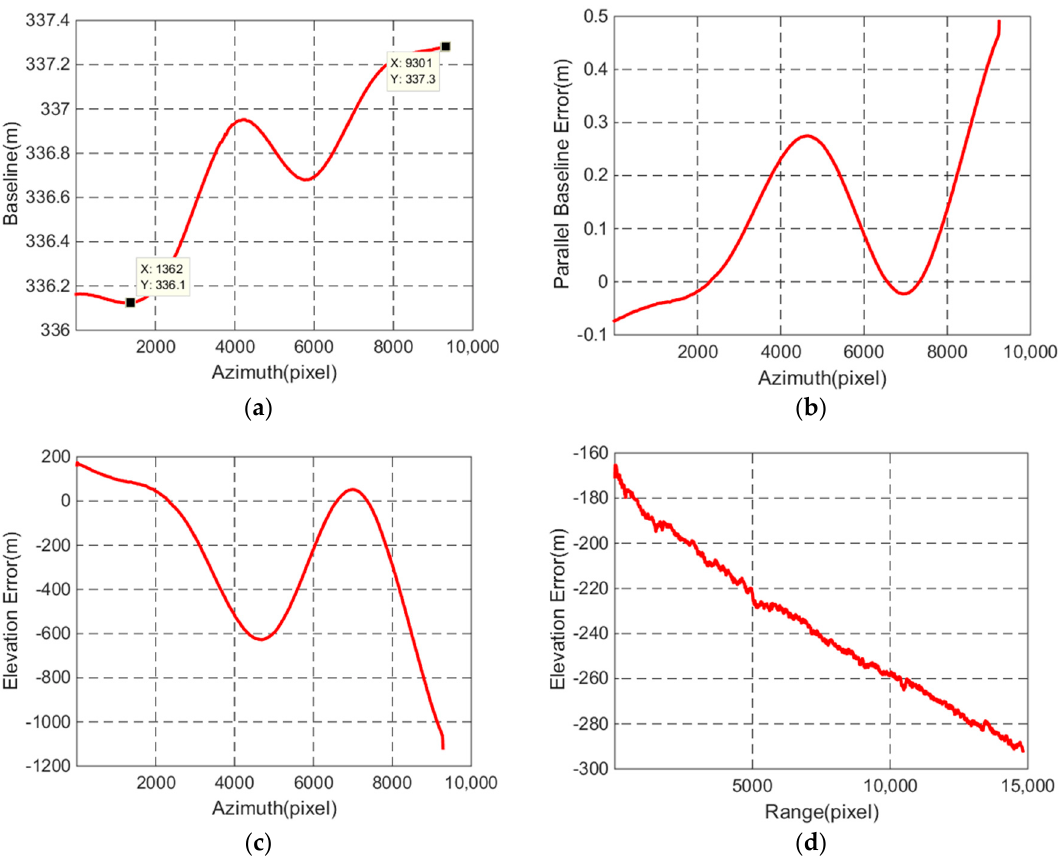
Figure 9. Different error curves: ( a ) description of the baseline length; ( b ) description of the parallel baseline error; ( c ) description of the vertical error in azimuth between SRTM DEM and the GF-3 generated DEM; ( d ) description of the vertical error in range between SRTM DEM and the GF-3 generated DEM.